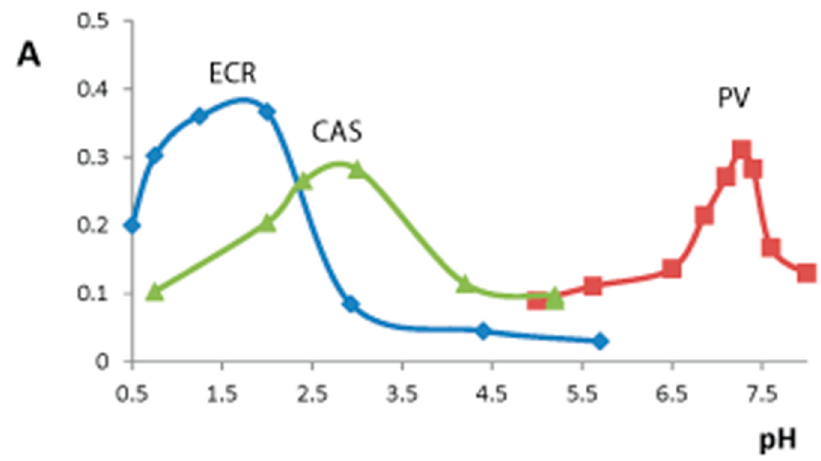
Figure 2. The effect of pH on silica–titania xerogels absorbance after the interaction with 1 × 10 − 4 M triphenylmethane dyes solution. PV—pyrocatechol violet ( λ 640 nm), ECR—eriochrome cyanine R ( λ 570 nm), CAS—chrome azurol S ( λ 550 nm). m/V = 0.10 g/5.0 mL, time of contact is 20 min.